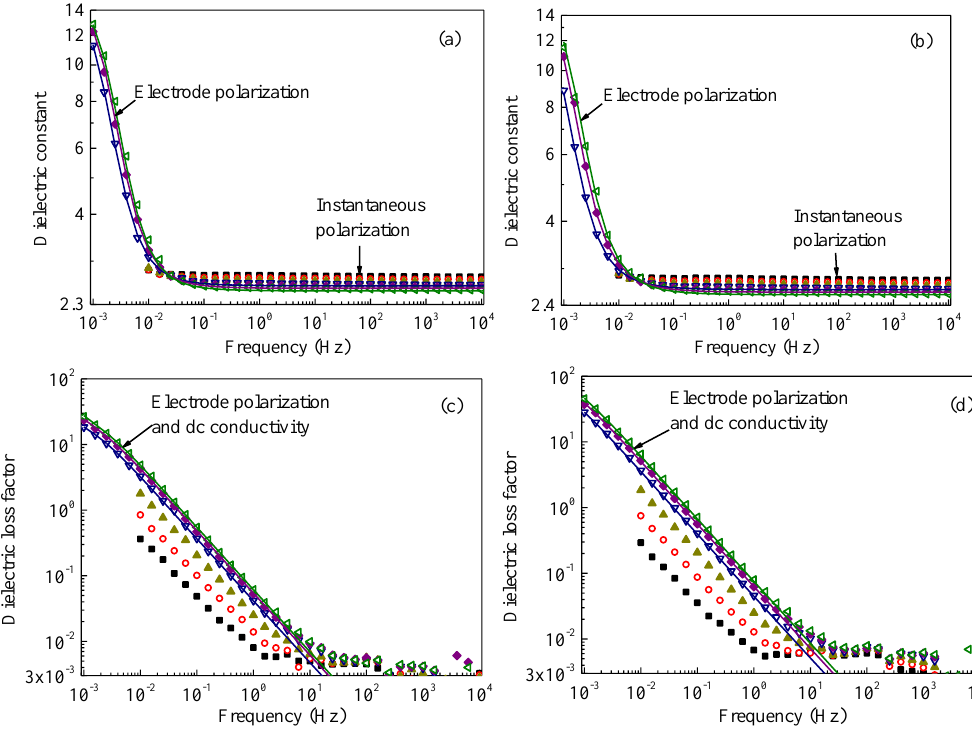
Figure 3. Dielectric constant r ′ and dielectric loss factor r " each as a function of frequency, measured at various temperatures. Dielectric constant r ′: ( a ) irradiated at 145 °C for 900 h and ( b ) irradiated at 145 °C for 1500 h. Dielectric loss factor r ": ( c ) irradiated at 145 °C for 900 h and ( d ) irradiated at 145 °C for 1500 h. Symbols and solid curves represent the data obtained experimentally and numerically, respectively. The measurements were conducted at 100 °C ( ), 120 °C ( ), 140 °C ( ), 160 °C ( ), 180 °C ( ), and 200 °C ( ).